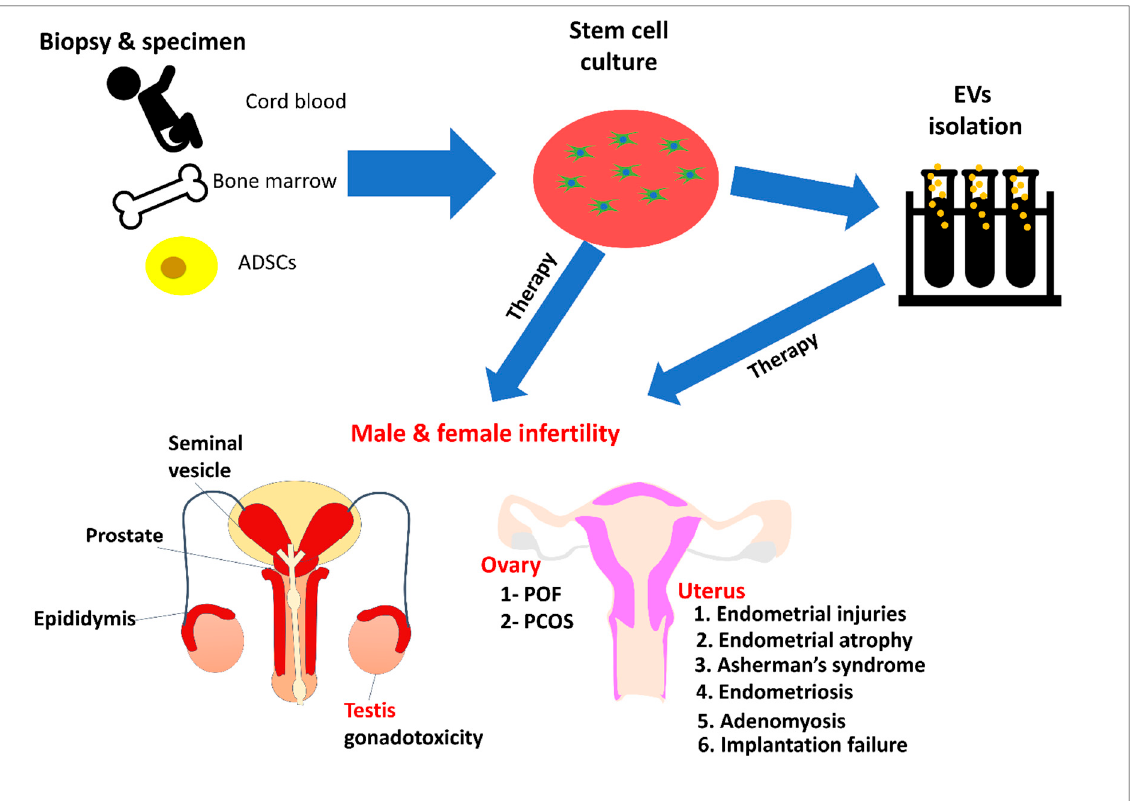
Figure 2. Diagrammatic illustration of the uses of stem cells (SCs) and their derived extracellular vesicles (EVs) for treating male and female infertility. Stem cells can be isolated from different sources such as cord blood, bone marrow, and adipose-derived stem cells (ADSCs) and used for culture and propagation. Cultured stem cells are used for isolating EVs from their conditioned medium. SCs and/or EVs can be administered to treat infertility diseases. POF: Premature ovarian failure. PCOS: Polycystic ovarian syndrome.